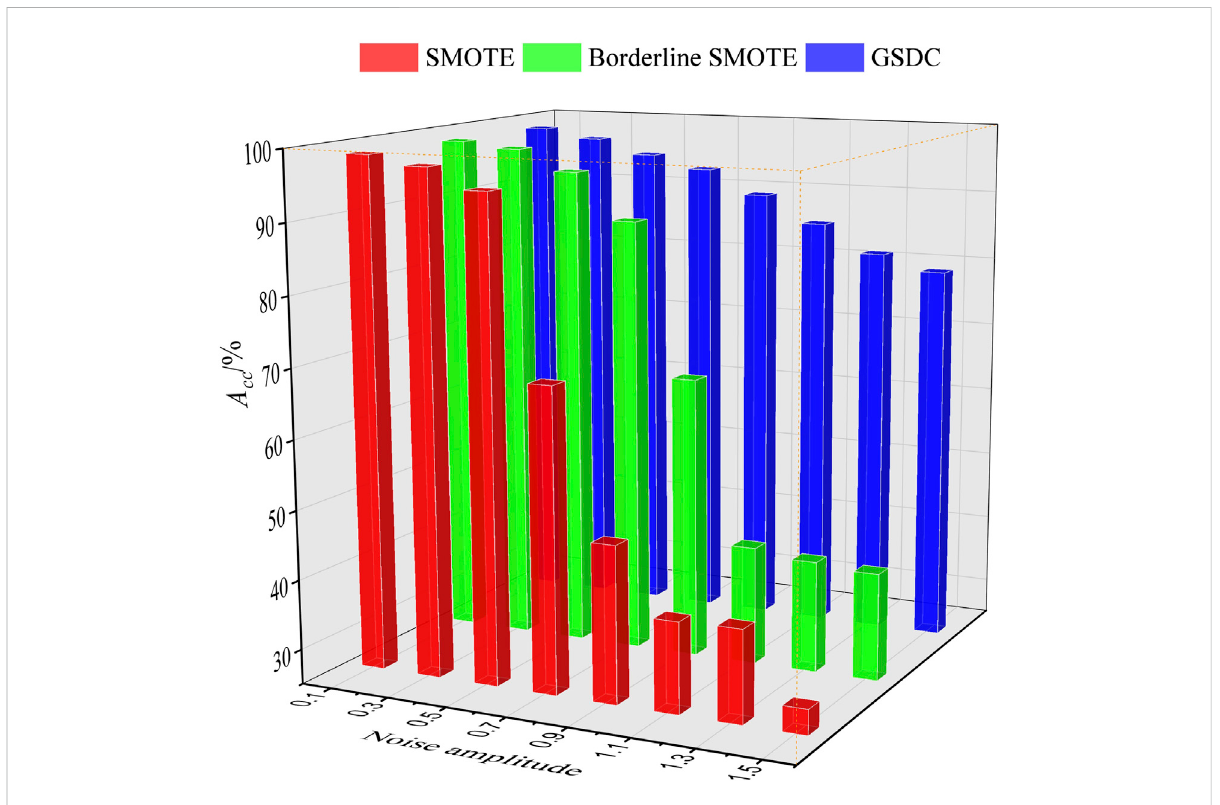
FIGURE 3 The classi fi cation accuracy based on different class balancing algorithms and different levels of